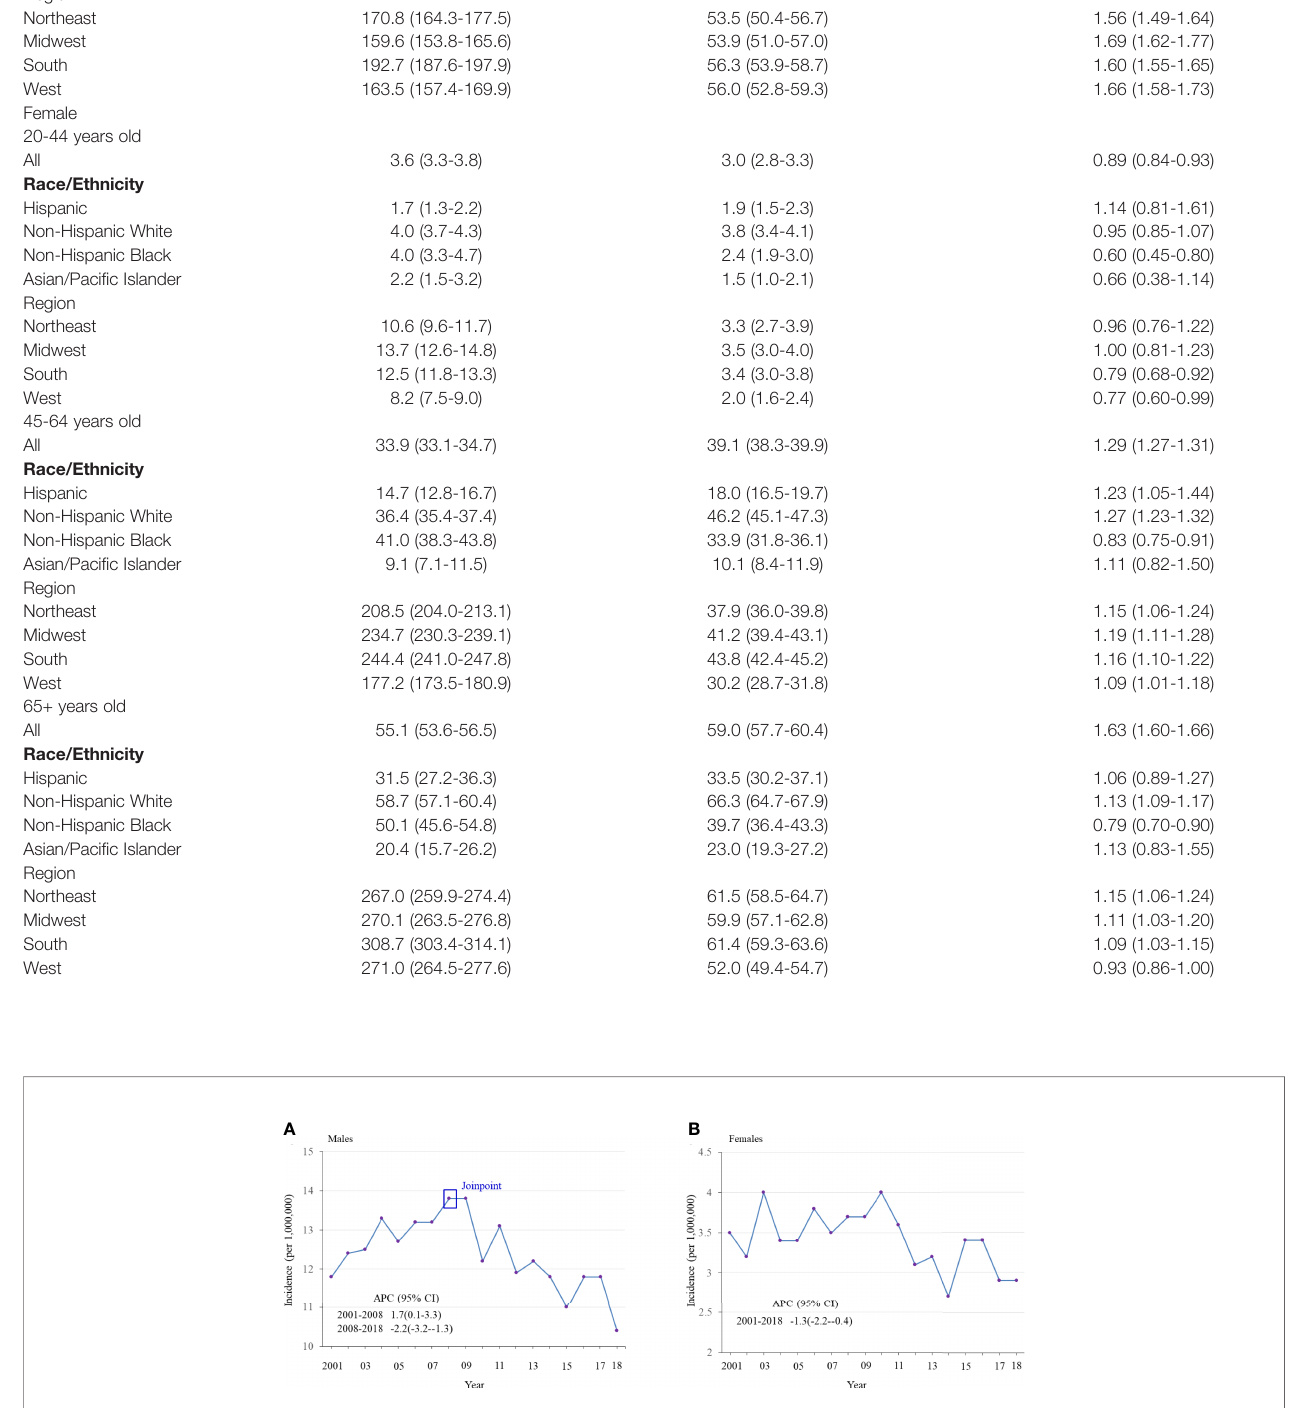
FIGURE 1 | Age-adjusted incidence of HPV-related oropharyngeal squamous cell carcinoma (OPSCC) from 2001 to 2018 among adults 20-44 years old, strati fi ed by sex. (A) Males (B) Females.